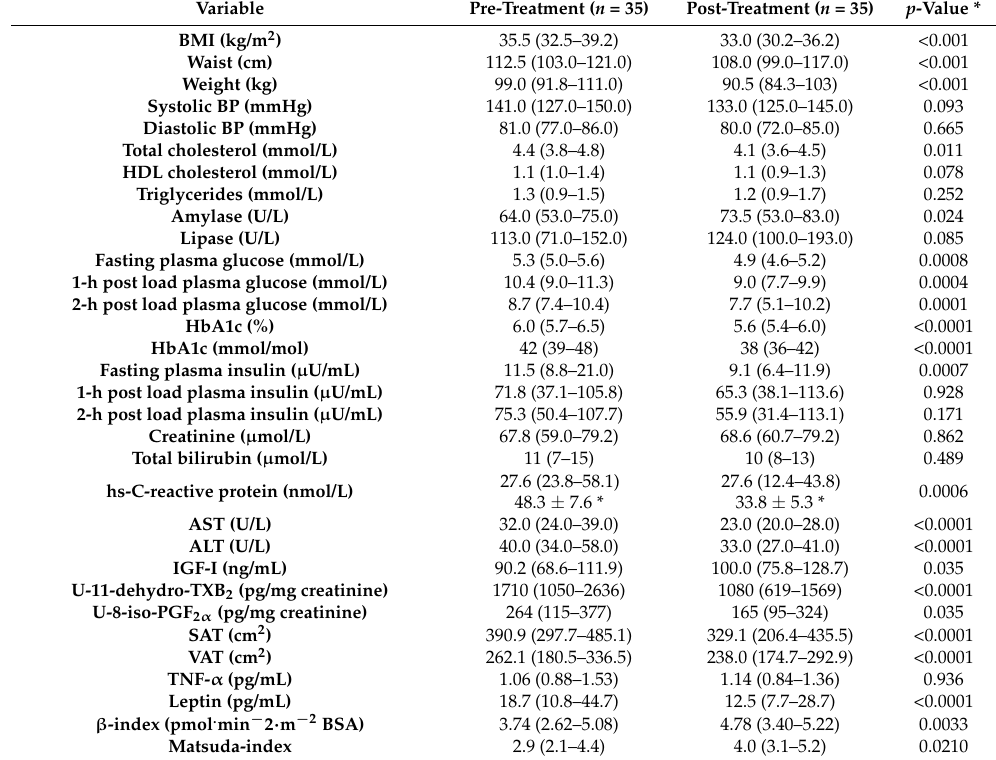
Table 3. Clinical, biochemical and imaging parameters of obese patients before and after treatment-induced weight loss.